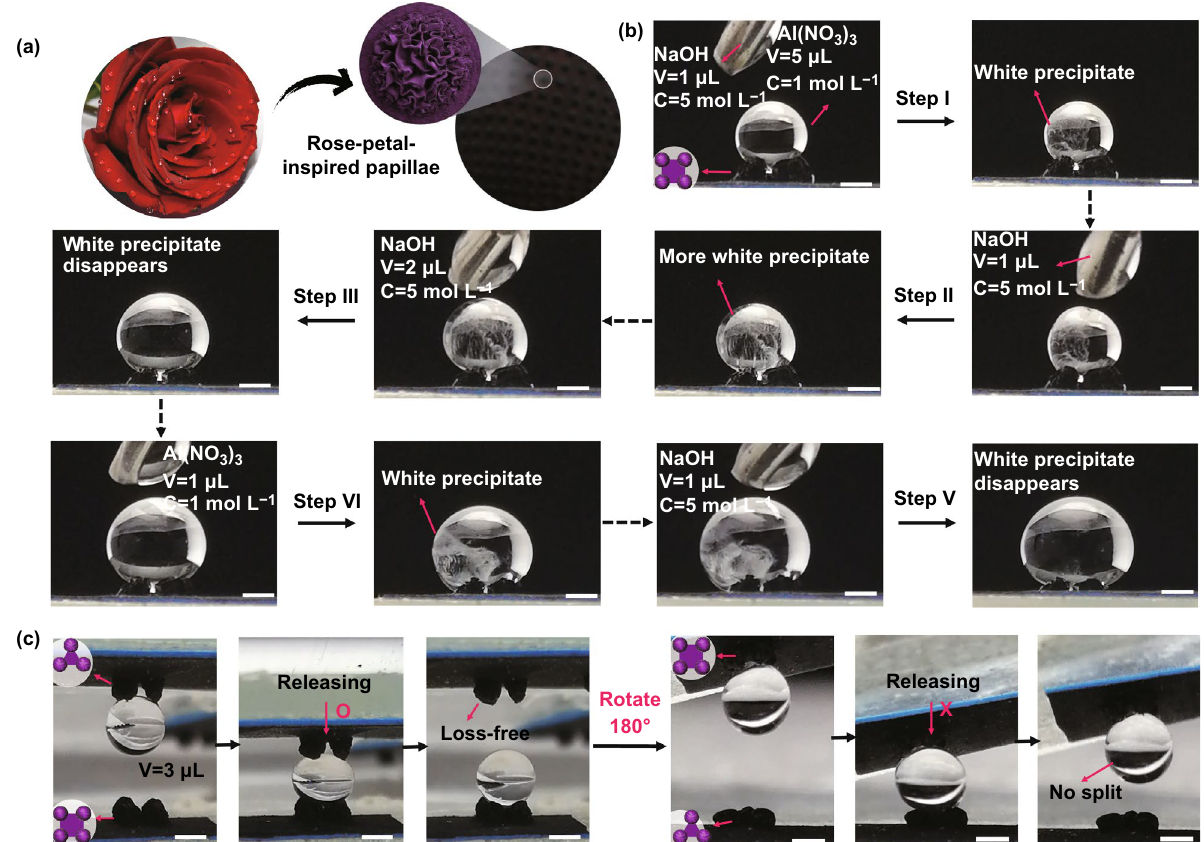
Fig. 14 Superhydrophobic papillae arrays for microdroplet manipulation. a Rose-petal-inspired papillae array and SEM image of a papillae with fake colours. b Demonstration of the multi-step microreaction platform. c Snapshots show one-way transfer of a droplet between triangle array ( N = 3) and square array ( N = 4). All scale bars in the images are 1 mm [54]. Copyright 2019